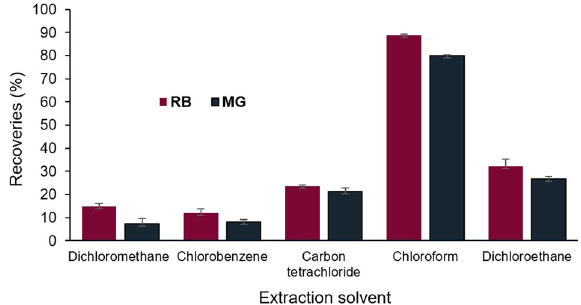
Fig. 1 In fl uence of type of extraction solvent on extraction ef fi ciency of the dyes. Extraction conditions: water sample volume: 10 mL, spiked concentration: 500 ng mL − 1 , dispersive solvent: ethanol (760 µL), sonication time: 4 min, pH: 5, centrifuge rate: 3500 rpm. Error bars represent standard deviations.